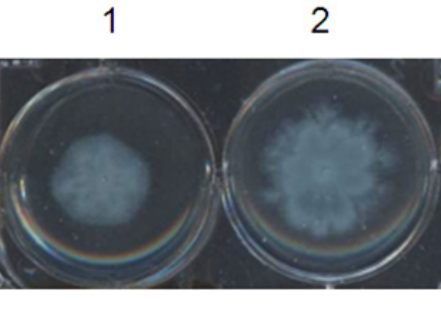
Figure 4. Effect of F5 on swarming assay of P. aeruginosa PAO1. Swarming agar plates supplemented with 50 μ g/mL F5 ( 1 ), without F5 ( 2 ) were stab inoculated with a sterile